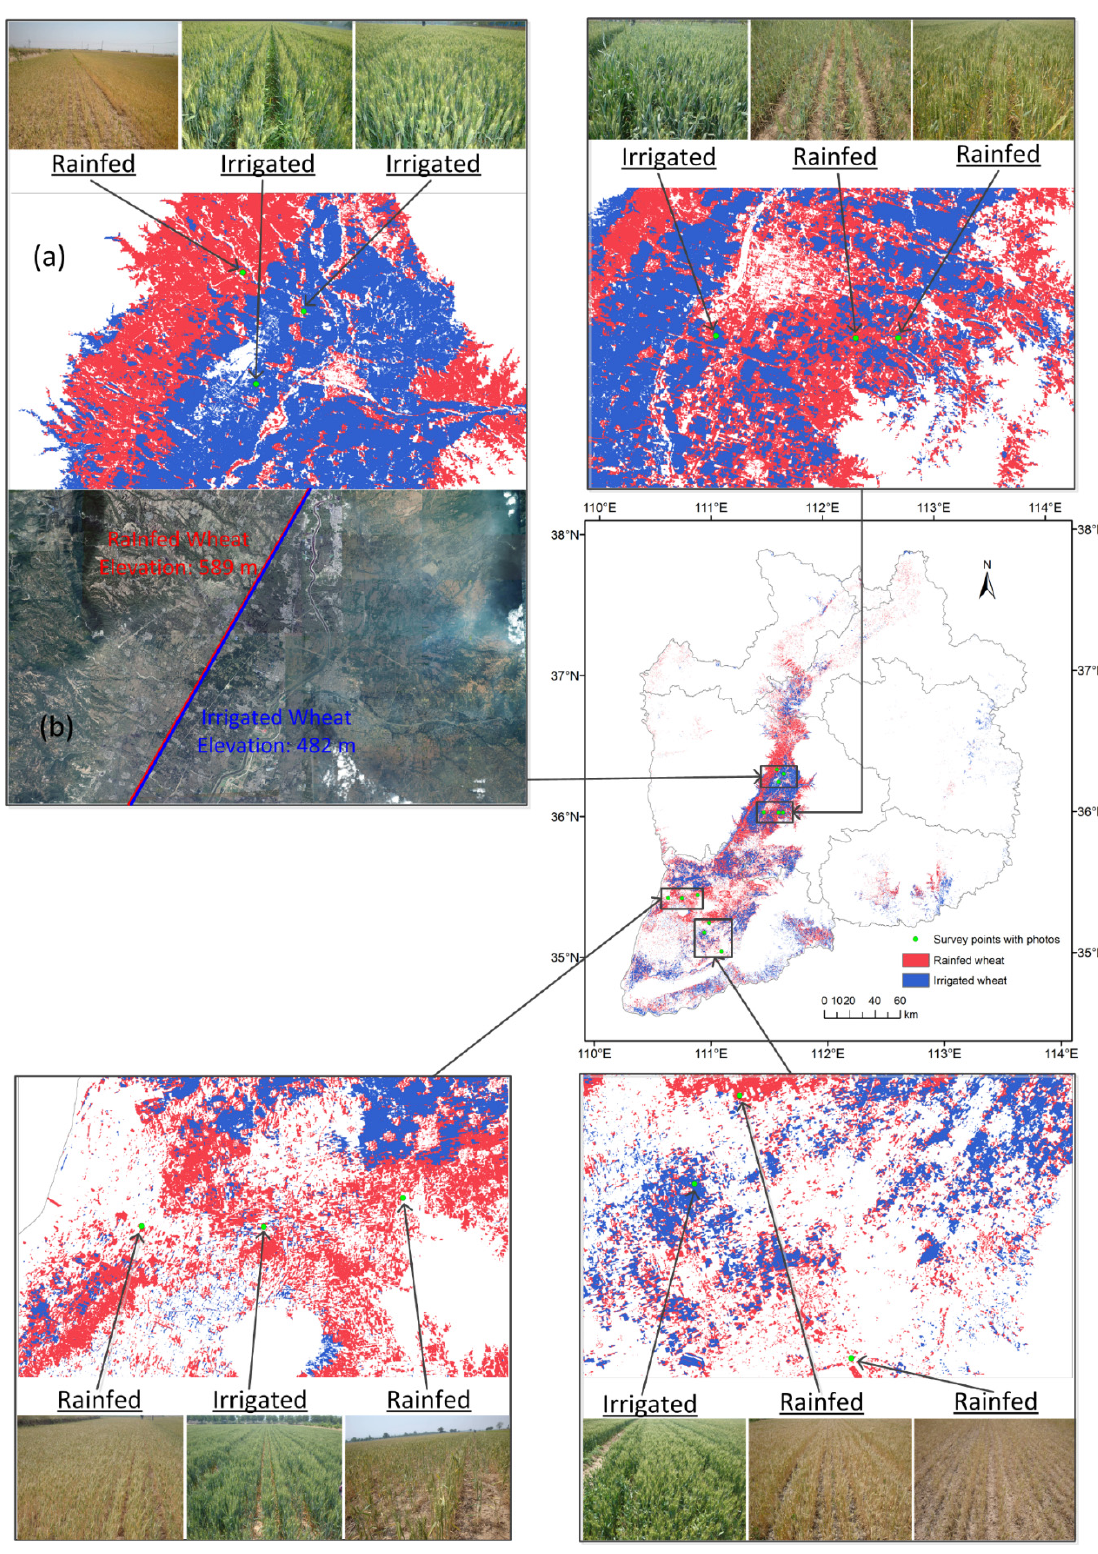
Figure 6. Spatial distribution of irrigated and rainfed wheat in south central Shanxi Province. ( a ) is the classification of irrigated and rainfed areas for a region that containing three survey sites; ( b ) is the Google Earth image of the same region that corresponding to ( a ).